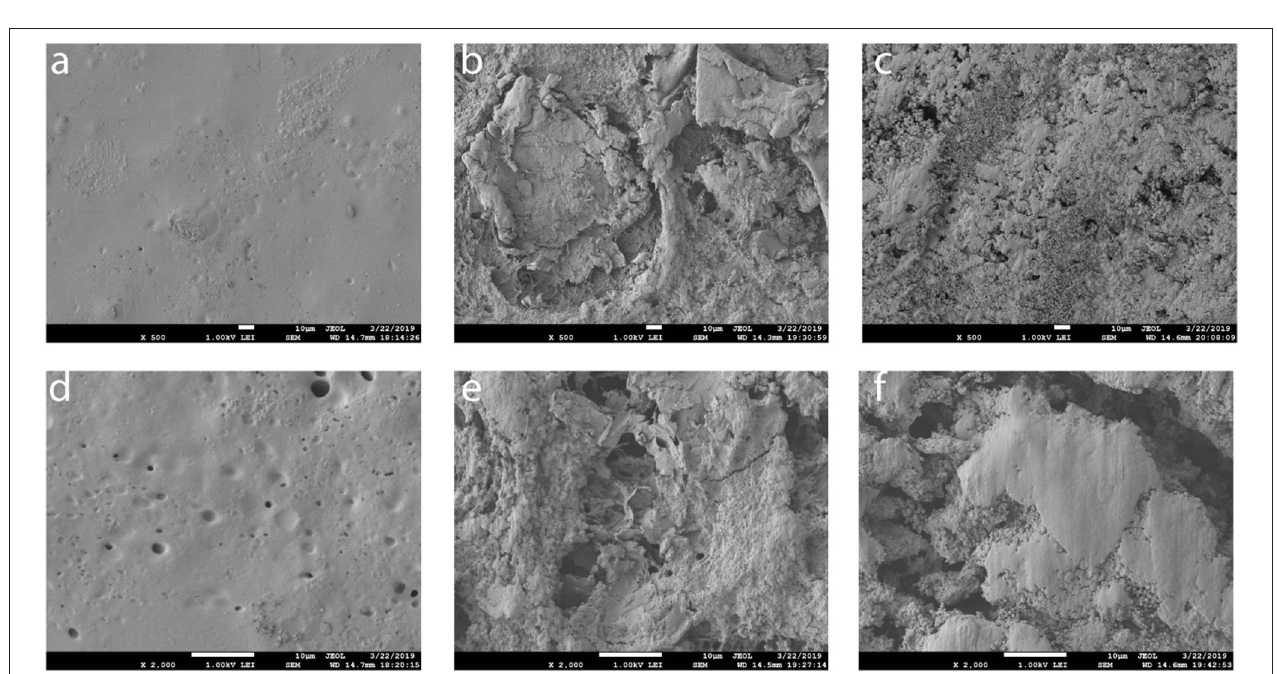
FIGURE 9 | Scanning electron microscope (SEM) of steel and Gr-coated steel treated by polymer binder. (a,d) Steel + binder, (b,e) steel + binder + Gr, (c,f) steel + binder + Gr + THFS.